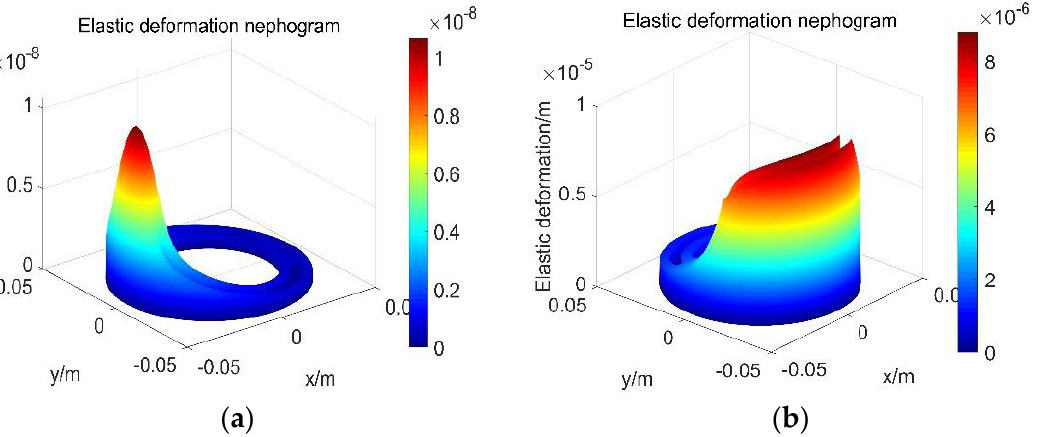
Figure 6. Elastic deformation distribution of oil film ( a ) elastic deformation distribution; ( b ) elastic deformation distribution under 35 MPa.